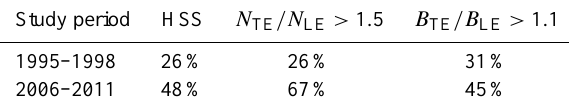
Table 3. Percentages of magnetic clouds during our two study pe- riods associated with a higher-speed trailing solar wind (HSS) and trailing density and magnetic field enhancements. For definitions see Sect.